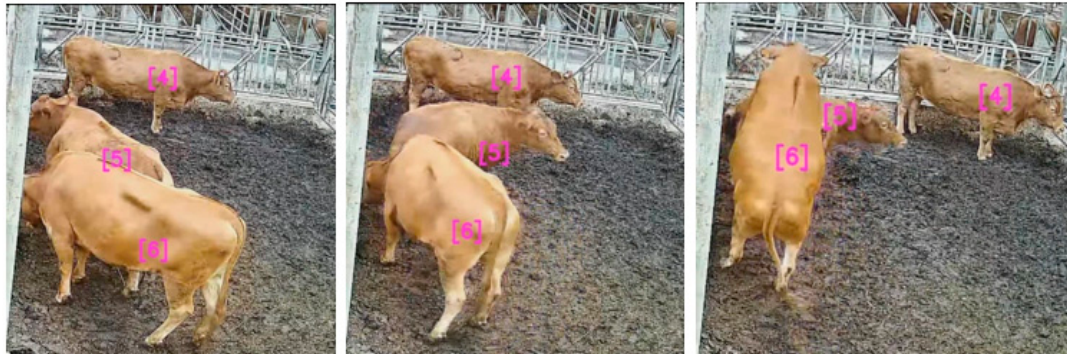
Figure 5. Identification of individual object IDs in a group of similar objects using the ARM.